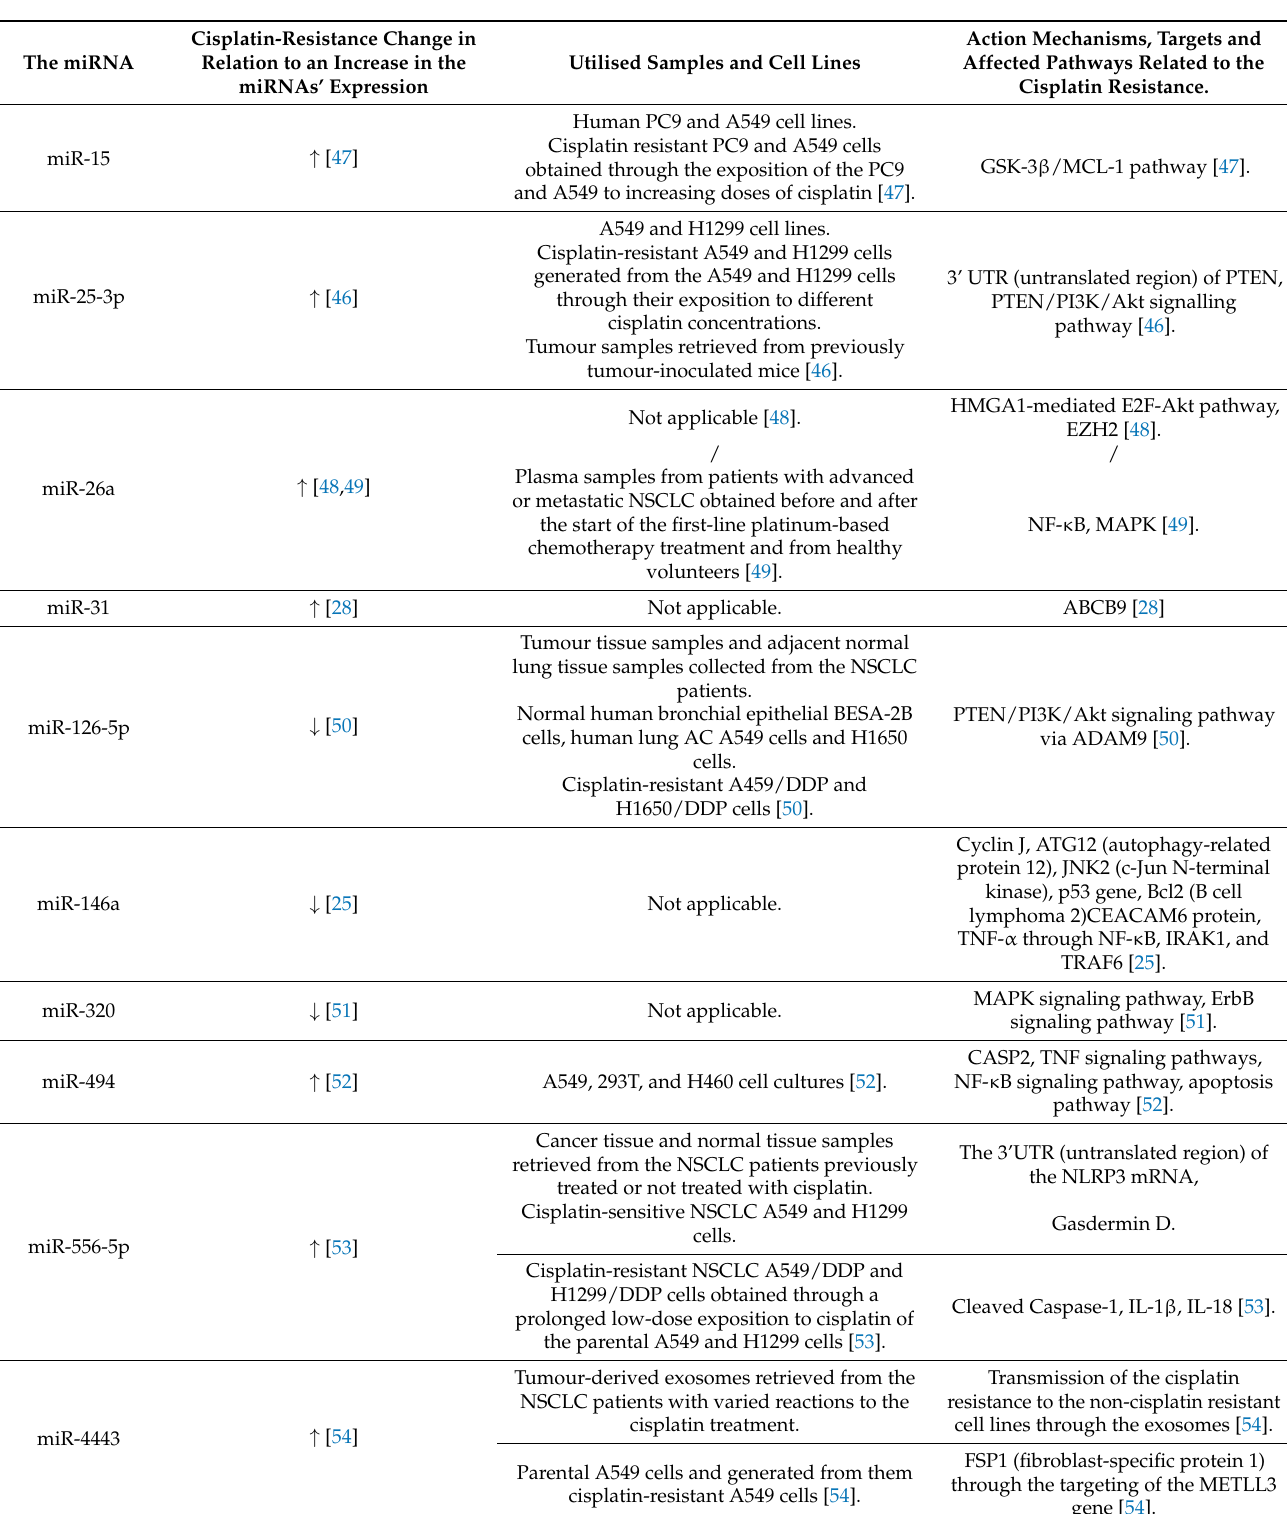
Table 2. The table below shows how the expression of certain miRNAs correlated with the